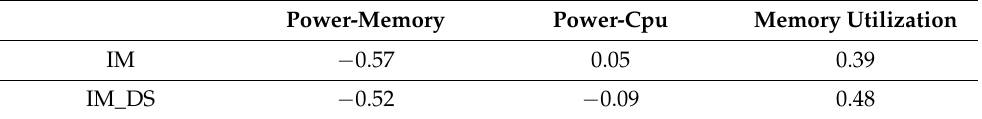
Figure 10. Power and utilization of in memory analytics and data serving on server #2. Table 5. Correlations among power, memory and CPU utilization running in-memory analytics on server #2.